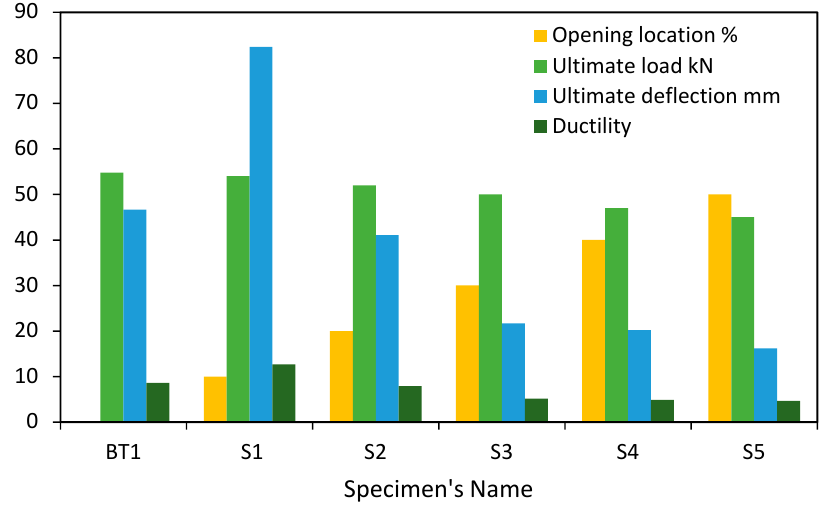
Figure 13. Results of the first group specimens in parametric case studies.